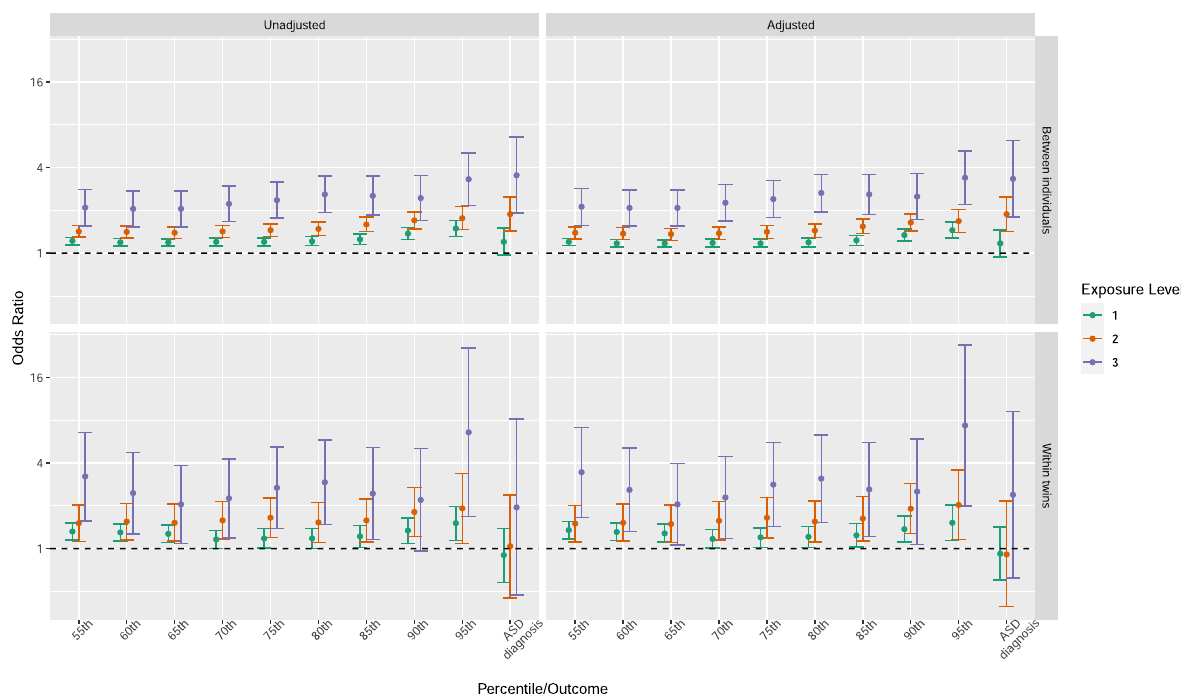
Fig. 2 Between individual (upper panels) and within twin-pair (lower panels) associations between the cumulative exposure load of early medical factors and a diagnosis of ASD, and being above each percentile cut-off of autistic symptoms, respectively. Forest plots illustrating odds ratios (ORs, dots) and 95% con fi dence interval (CI, bars) for unadjusted associations to each exposure level (left panels), and sex and birth year adjusted between individual (upper right panel) and familial confounding and sex adjusted (lower right panel) within twin associations.